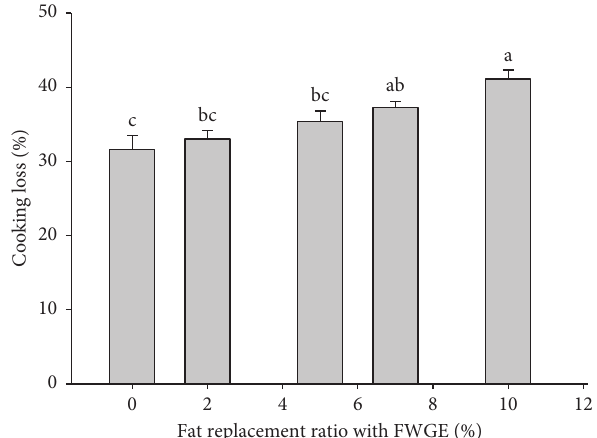
Figure 1: Cooking loss of emulsified sausages with different ratios of fat replacement using FWGE. Table 5: Texture properties analysis of emulsified sausages with different concentrations of FWGE. FWGE (%) Hardness (g) Resilience (%) Springiness (%) Cohesiveness